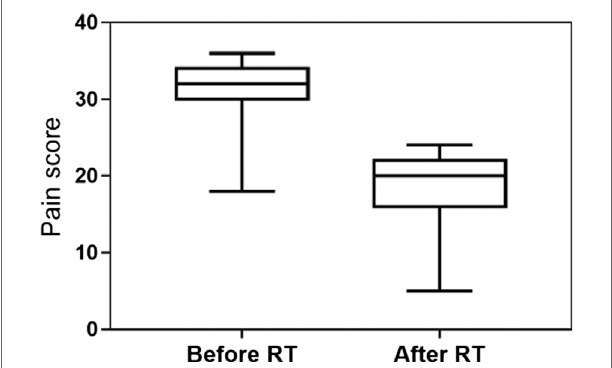
FigUre 3 | Pain score evaluated at presentation and 3 weeks after low-dose radiation therapy in 23 dogs. The median pain score decreased from 3 (range 1–4) to 2 (range 1–4) after RT ( P < 0.001).